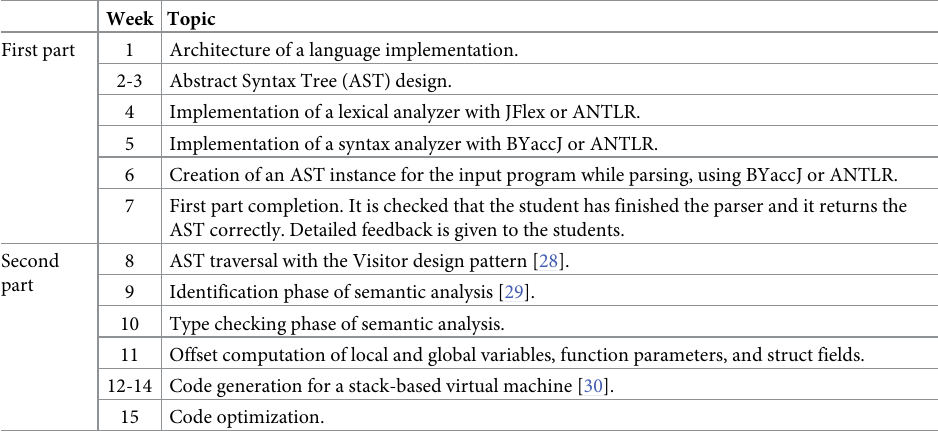
Table 3. Lab distribution per